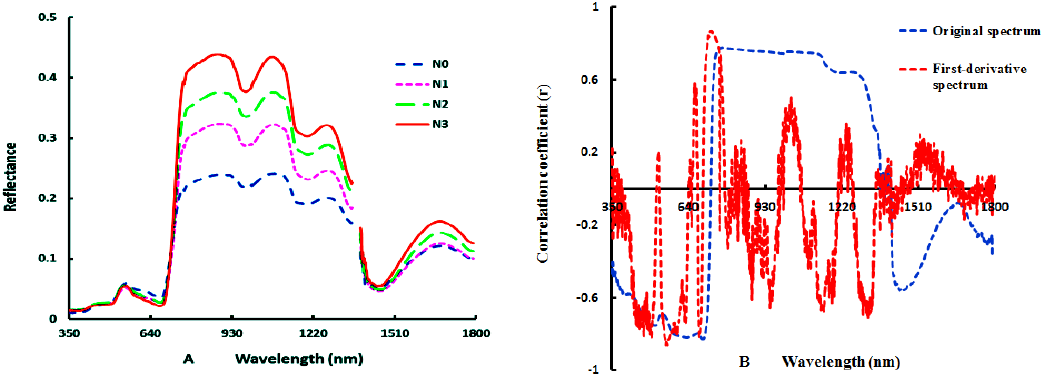
Figure 1. ( A ) Canopy spectral reflectance under four N rates at booting for Yumai 34 in Experiment 3; ( B ) Correlation of the LNC with the original and first derivative